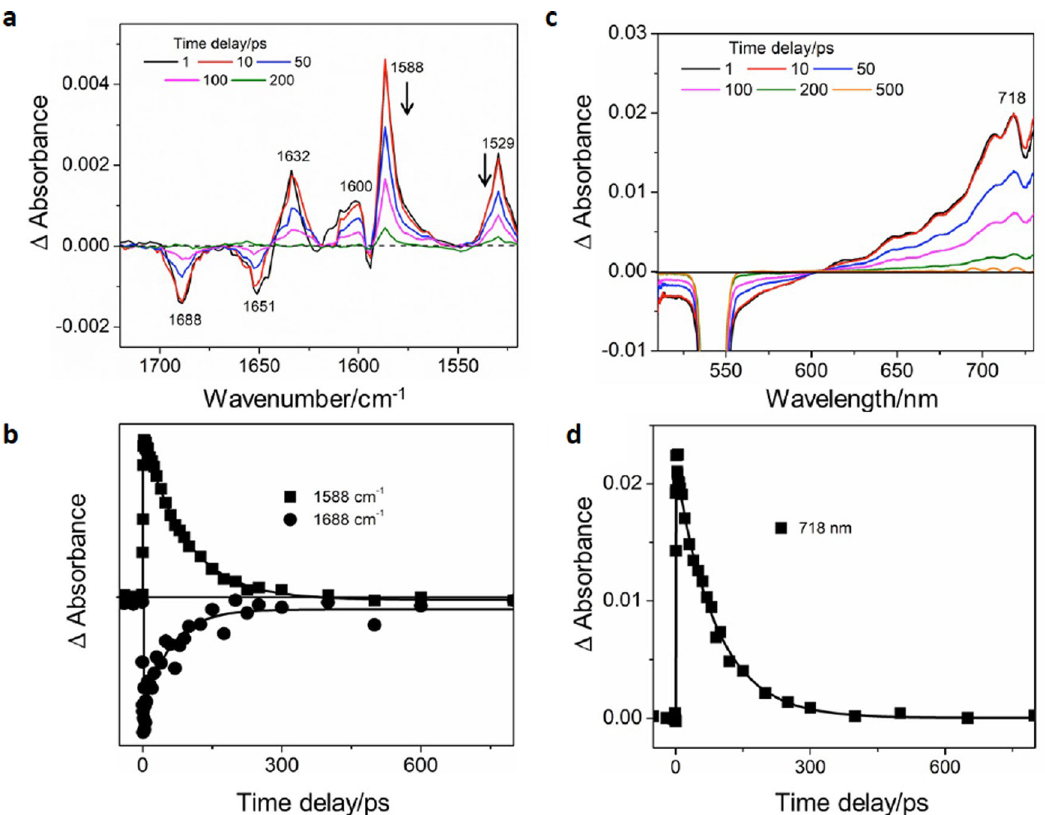
Fig. 7 Time resolved spectroscopic studies of [PDI-BN38C10-(P5A) 2 ] 2 + . TRIR and TA results of [PDI-BN38C10-(P5A) 2 ] 2 + probed after 532 nm photoexcitation in CH 2 Cl 2 , showing ( a ) the ps-TRIR spectra at selected time delays. The arrows indicate decay of PDI • − bands which are formed within <1 ps. b Amplitude kinetics for selected peak frequencies with fi t. The squares and circles show experimental points. The continuous lines show the best- fi t lines. c ps-TA spectra at selected time delays. d Kinetic trace with fi t for selected probe wavelength. The squares show experimental points. The continuous line shows the best- fi t